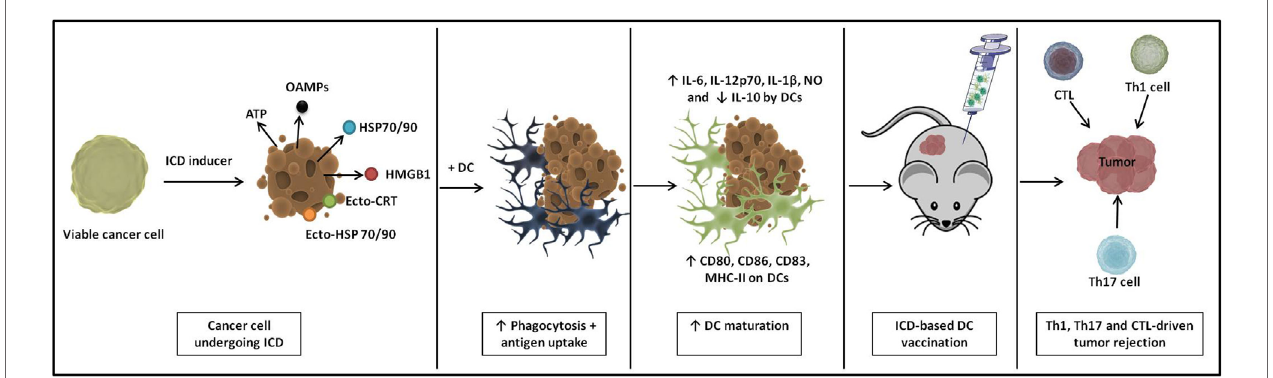
FiGURe 2 | A schematic representation of immunogenic cell death (iCD)-based DC vaccines. ICD causes cancer cells to emit a spatiotemporally defined pattern of danger signals. Upon loading of these ICD-undergoing cancer cells onto DCs, they induce extensive phagocytosis and antigen uptake. Loaded DCs show enhanced phenotypic and functional maturation and immunization with these ICD-based DC vaccines instigates Th1-, Th17-, and cytotoxic T lymphocyte (CTL)-driven antitumor immunity in vivo